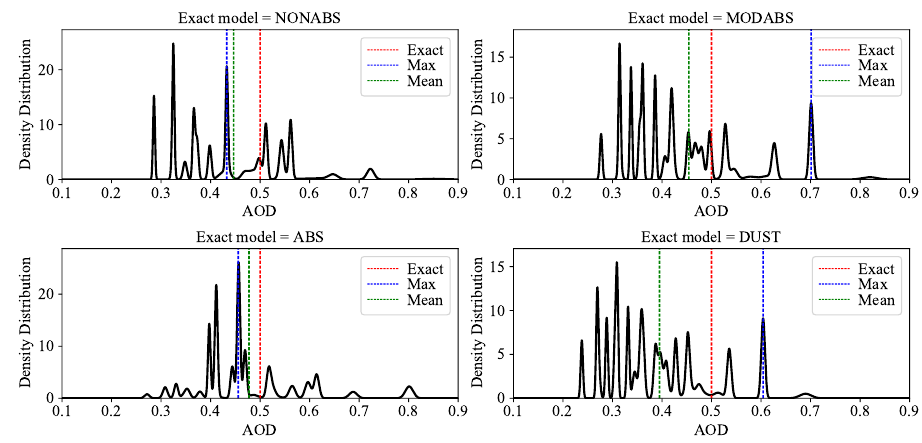
Figure 7. The same as in Figure 6 but for the mean a posteriori densities p mean ( τ | y δ )